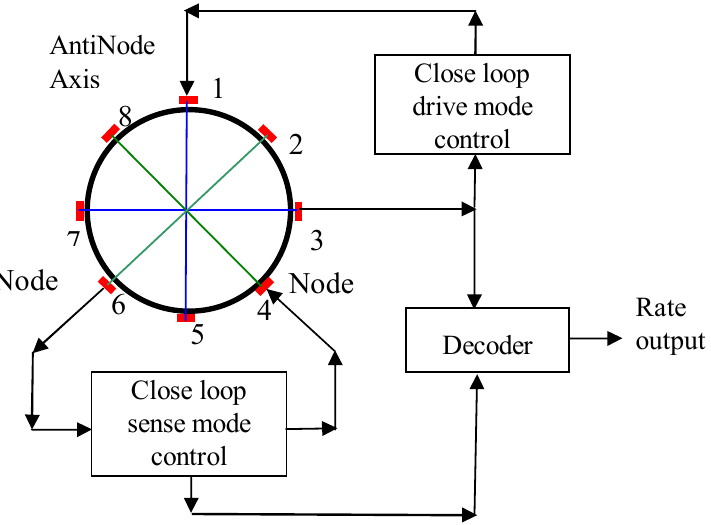
Figure 3. The signal processing circuit for the cylinder